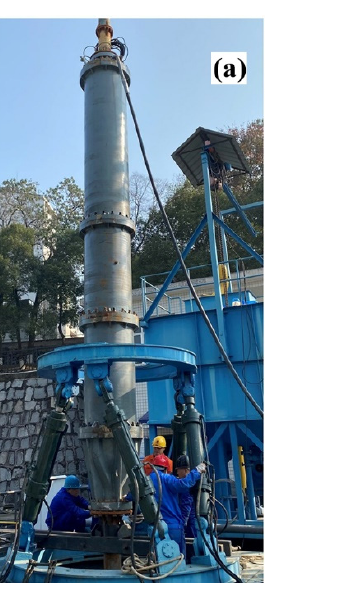
Figure 9. A two-stage centrifugal deep-sea mining pump of Central South University.